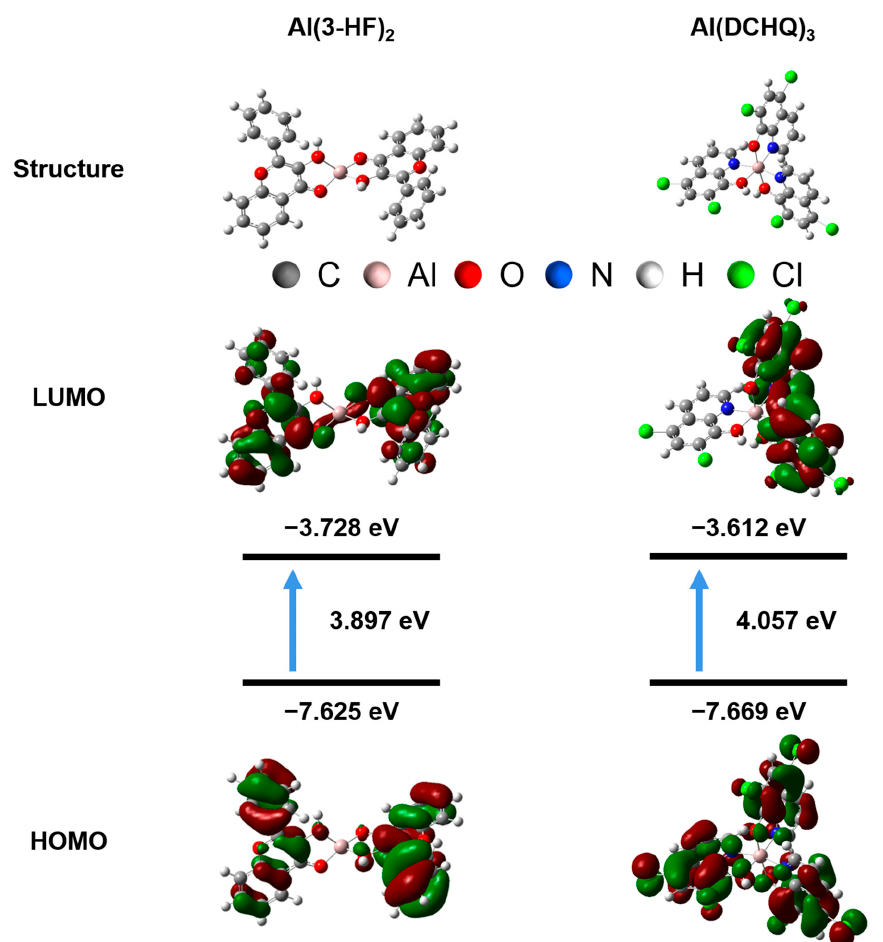
Figure 5. Energy − level diagram containing the HOMO and LUMO for Al(3-HF) 2 and Al(DCHQ) 3 obtained from DFT calculations.